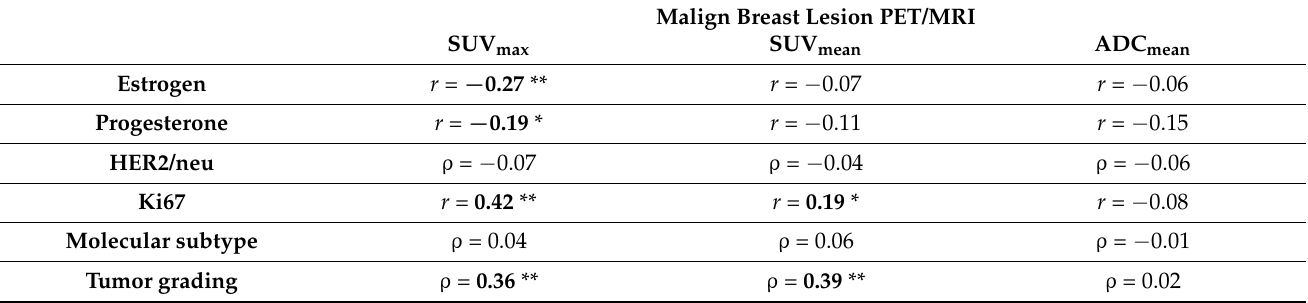
Table 2. Correlation between immunohistochemical markers (estrogen, progesterone, HER2, Ki67), molecular subtype, tumor grading in relation to SUV, and ADC measurements from [ 18